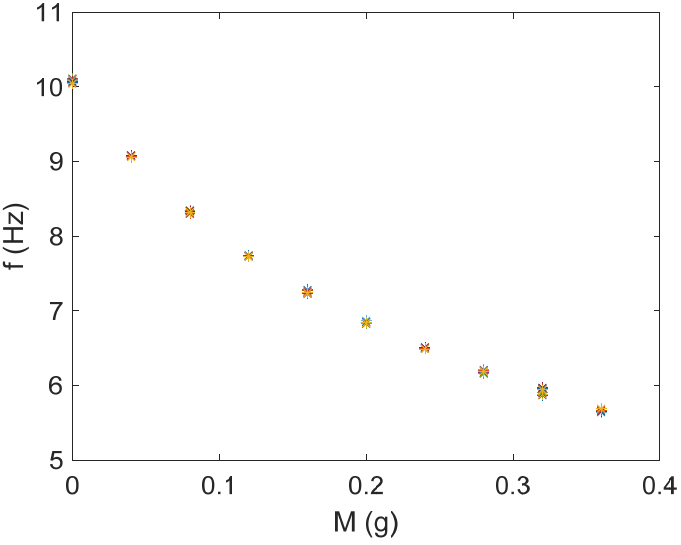
Figure 7. The sensor response for different values of the magnetic field, B , and the driving current, I d . Symbols represent different operating conditions. The device response is quite insensitive to I and B .